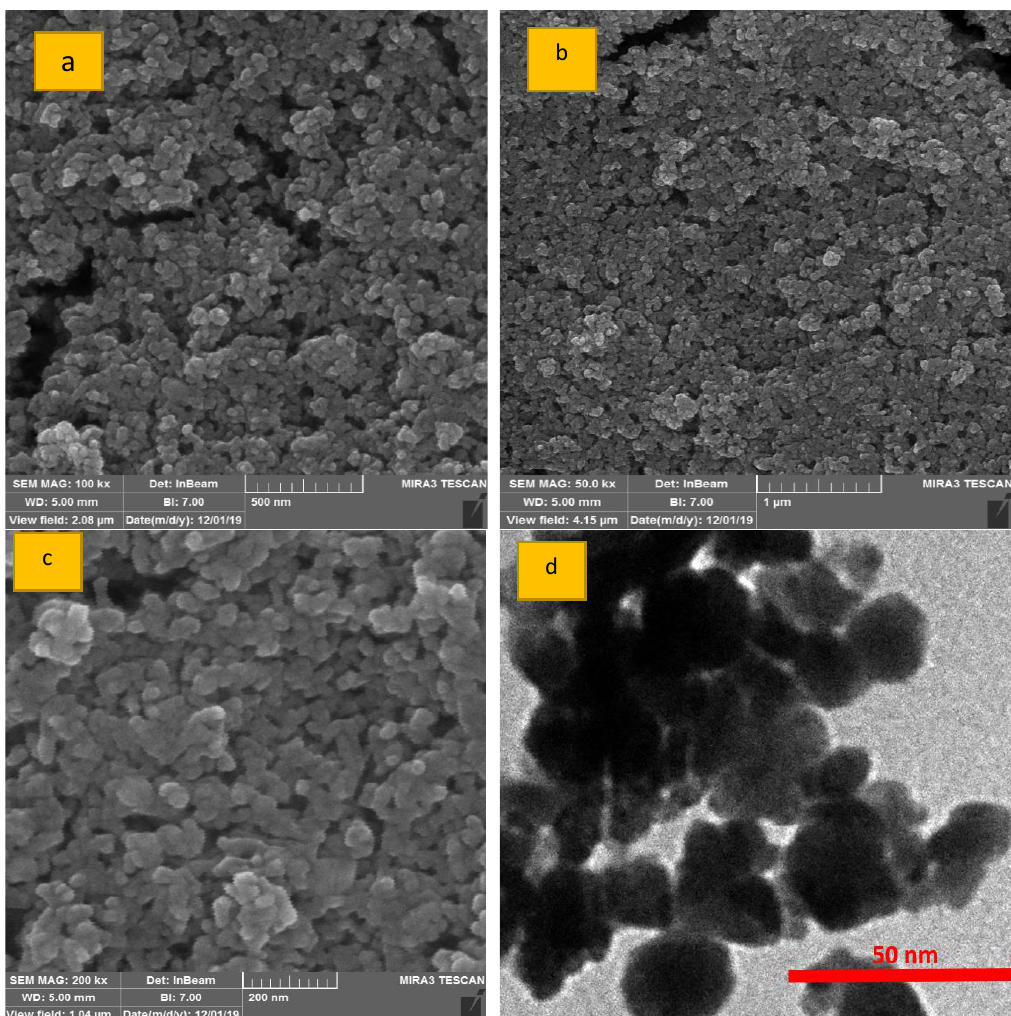
Fig. 4. a, b, c) FESEM of spherical Bi Figure 4 : a, b, c) FESEM of spherical Bi 2 O 3 NPs and d) TEM of spherical Bi 2 O 3 NPs